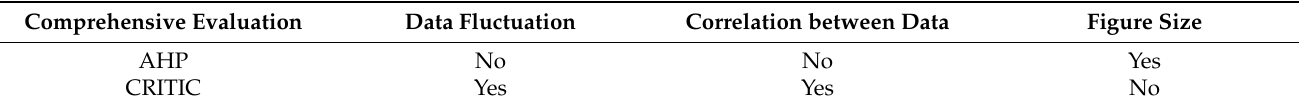
Table 2. Comparison of the CRITIC method and AHP method.